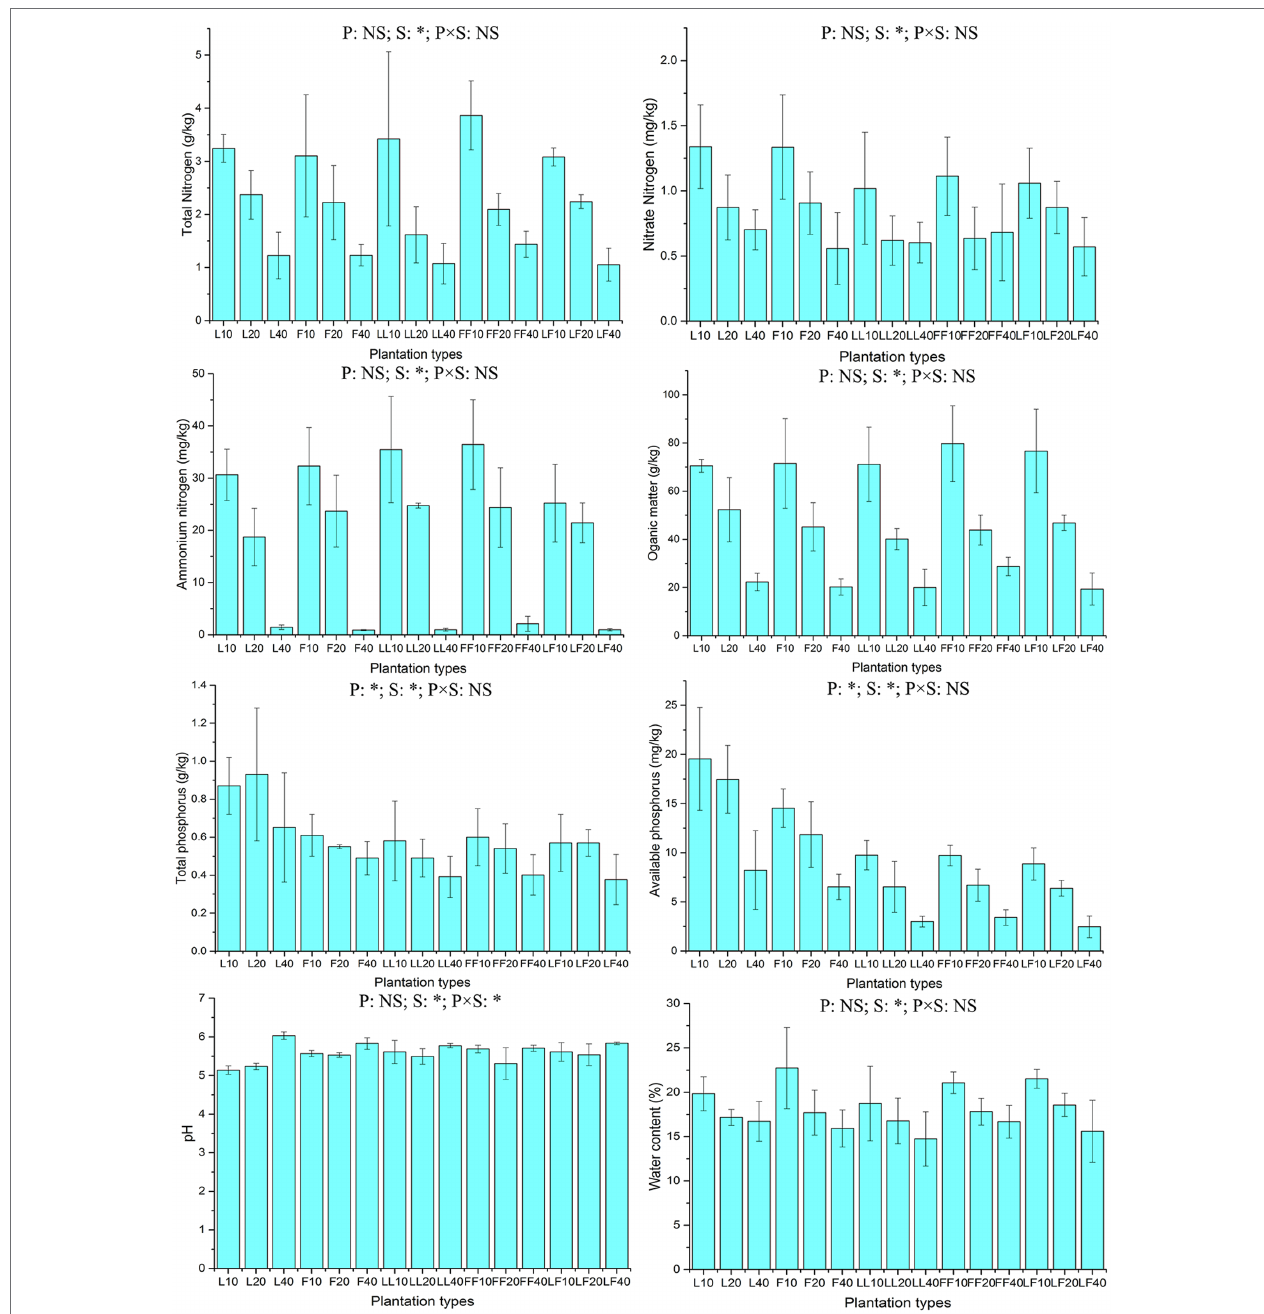
FIGURE 1 | Chemical properties of soil samples. L, Larix plantation; F, Fraxinus plantation; LL, Larix – Larix plantation belt in the mixed plantation; FF, Fraxinus – Fraxinus plantation belt in the mixed plantation; LF, Larix – Fraxinus plantation belt in the mixed plantation; P, plantation types; S, soil depths; NS, not significant. Error bars show standard errors of the mean ( n = 3). ANOVA of split plot results are reported. * p < 0.05. Numbers after letters represent soil depths of 0–10, 10–20, 20– 40